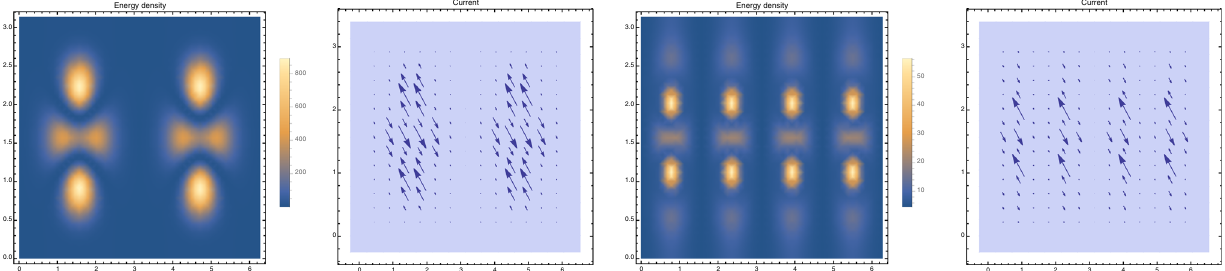
Fig. 2 From left to right, crystals of superconducting strings with B = 2 and B = 4, respectively. The current is concentrated in the tube-shaped regions defined where (most of) the E is contained, and